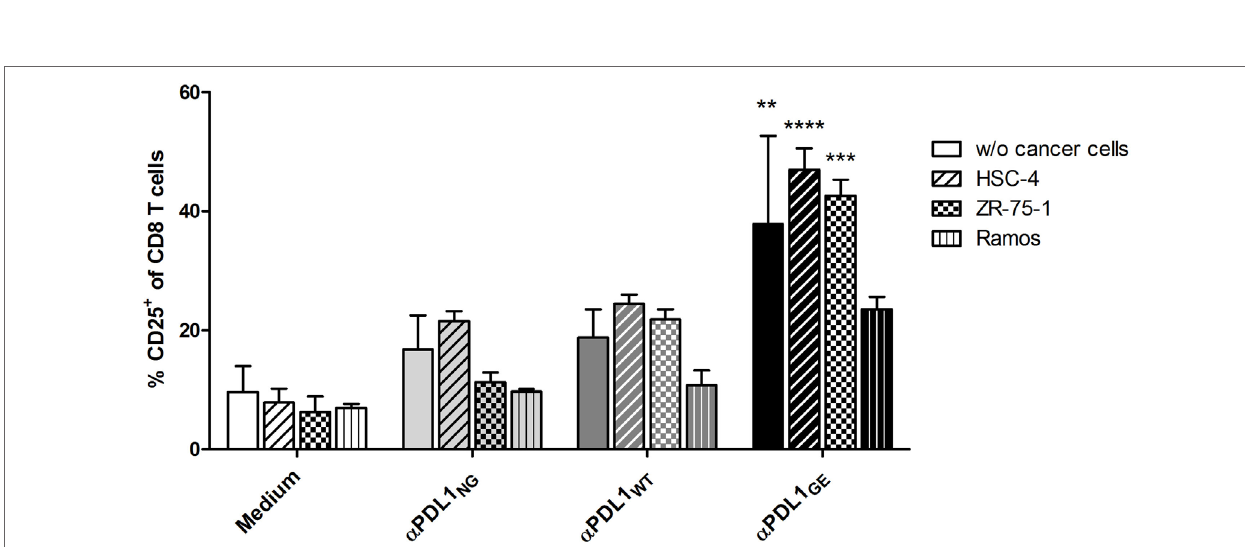
FigUre 5 | Glyco-engineered anti-human programmed death-ligand 1 (PD-L1) antibody induces increased CD8 T cell activation in presence of cancer cells. The three anti-PD-L1 variants α PDL1 NG (light gray bar), α PDL1 WT (dark gray bar), and α PDL1 GE (black bar) were tested for their effect on T cell activation (donor A) in allogeneic mixed leukocyte reaction (MLRs) in absence or presence of the cancer cell lines HSC-4 (horizontal stripes), ZR-75-1 (plaid), and Ramos (vertical stripes). MLR without addition of test antibody (medium; white bar) served as negative control. The relative frequencies of CD25 + in CD8 T cells were plotted. Statistics: mean and SD were plotted in all graphs. Data are representative of two independent experiments. Significance was tested against the medium control without presence of cancer wells (* p < 0.05; ** p < 0.01; *** p < 0.001; and **** p <